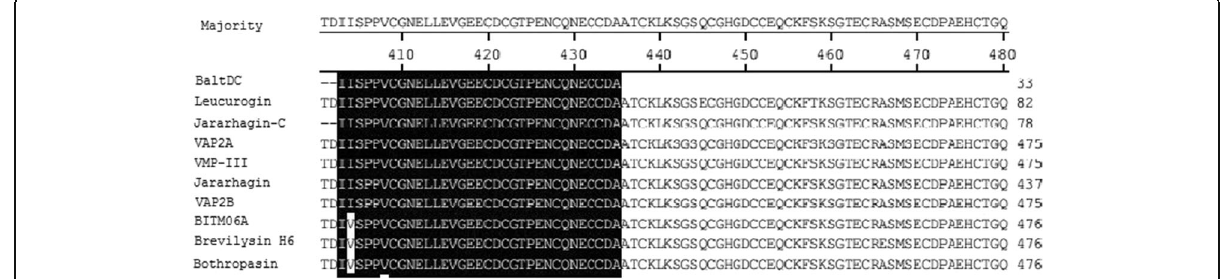
Fig. 2 Sequence alignment of BaltDC and members of the PIII SVMPs: jararhagin-C (AAB30855.1), leucurogin (P0DJ87.1), VAP2A (A4PBQ9.1), VMP- III (C9E1R8.1), jararhagin (P30431.1), VAP2B (Q90282.1), BITM06A (Q8QG88.1), brevilysin-H6 (P0C7B0.2) and bothropasin (O93523.2). The conserved residues are shown in black. The alignment and figure were generated and evaluated using BLAST (http://blast.ncbi.nlm.nih.gov/Blast.cgi)